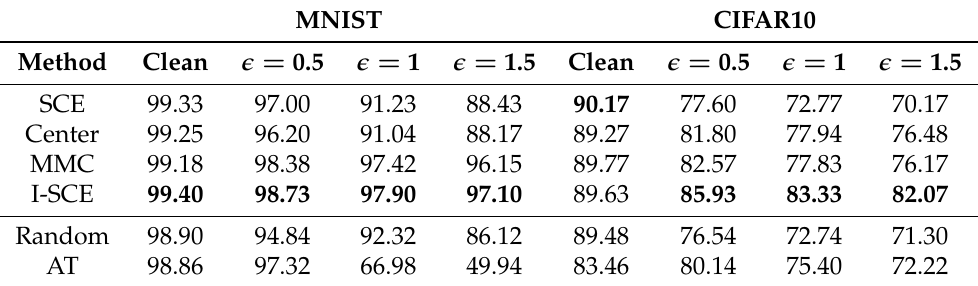
Table 3. Classification accuracy (%) under SimBA attack.